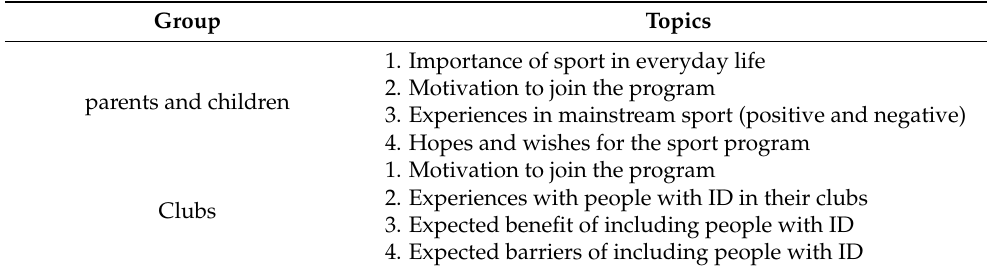
Table 2. Interview topics for qualitative program evaluation, divided by interview groups at t1. Group